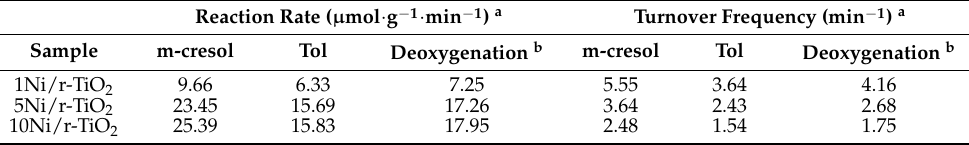
Table 5. The intrinsic reaction rate and turnover frequency (TOF) for HDO of m-cresol.